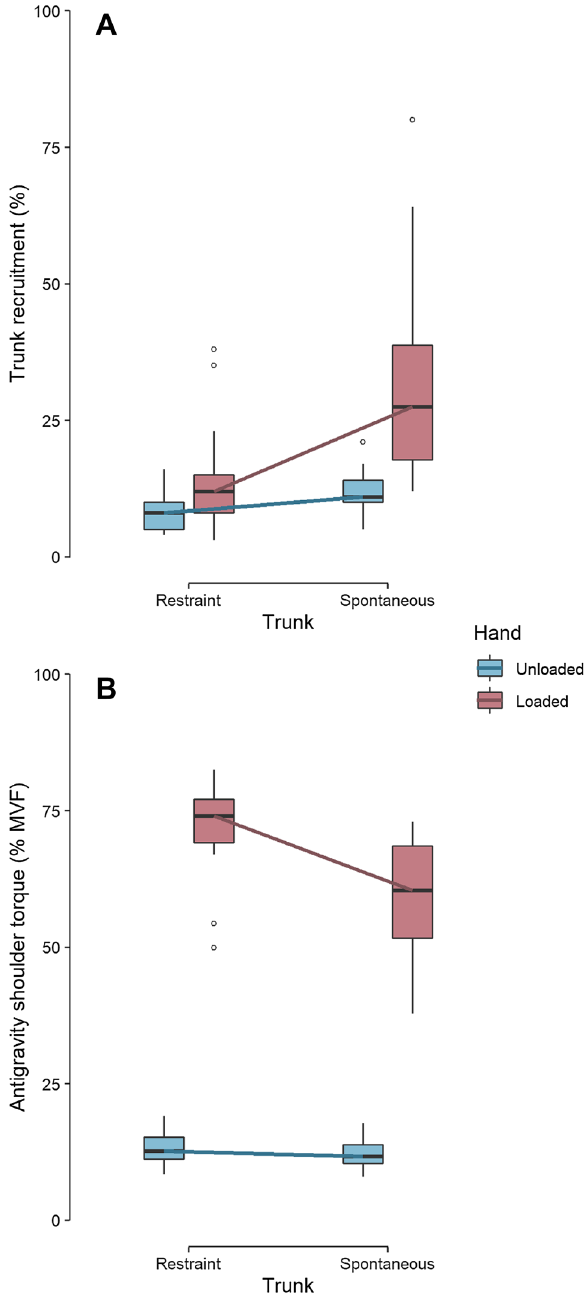
Figure 2. Trunk recruitment (Panel A ) and antigravity shoulder torque (Panel B ) as a function of trunk restraint and hand load. Trunk recruitment is in percentage of reach length. Antigravity shoulder torque at the final posture is in percentage of maximal voluntary shoulder torque. In each boxplot, the internal horizontal bar represents the median, boxes extend from first to third quartile, whiskers extend from minimal to maximal values excluding outliers and white circles represent outliers. All comparisons are statistically significant. The figure shows that trunk recruitment stays low in the unloaded conditions. When the hand is loaded, trunk recruitment is doubled, and antigravity shoulder torque is decreased by 18% in the spontaneous